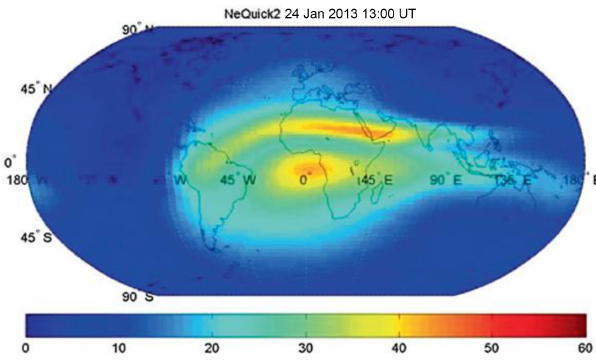
Figure 9. An example TEC map computed with NeQuick (http: //t-ict4d.ictp.it/, last access: 15 May 2018. Bottom scale is in TECU – 1 TEC unit = 10 16 electronsm − 2